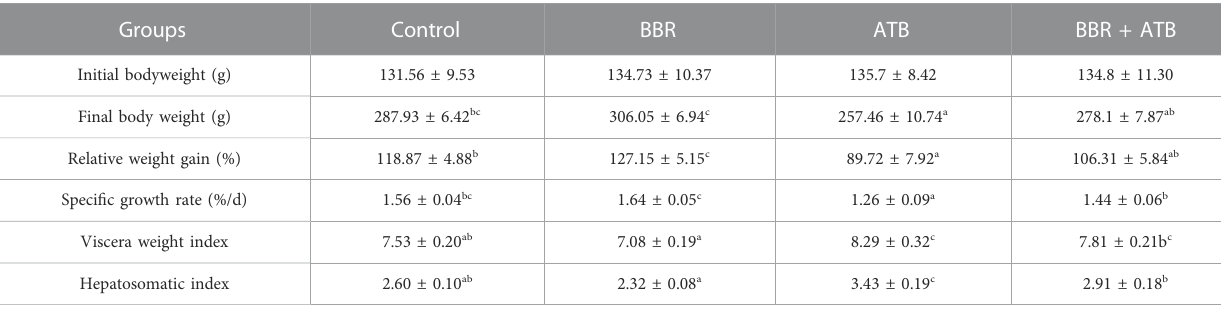
TABLE 2 Effects of BBR and/or ATB on the growth performance of largemouth bass. Groups